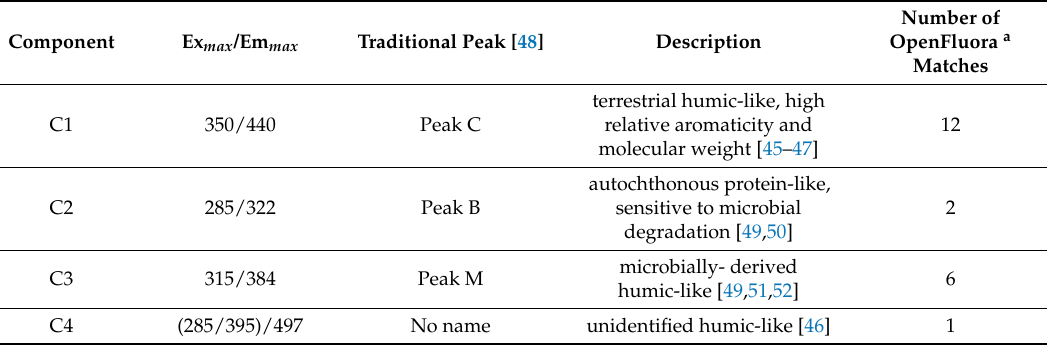
Figure 6. PARAFAC model output showing the fluorescent signatures of the four PARAFAC components inlittoral zones of Lakes Taihu and Hongze. Contour plots present the spectral shapes of excitation and emission. Line plots at right side of each contour plot present split-half validation results for the corresponding component and shows the excitation ( left ) and emission ( right ) spectra of six unique split halves and the overall model. For each component these lines are nearly superimposed; the very similar shape of the components provides a nearly perfect validation of the fluorescence signatures. Table 2. Spectral characteristics of excitation and emission maxima of four fluorescent components identified by PARAFAC analyses compared to the OpenFluor online database.